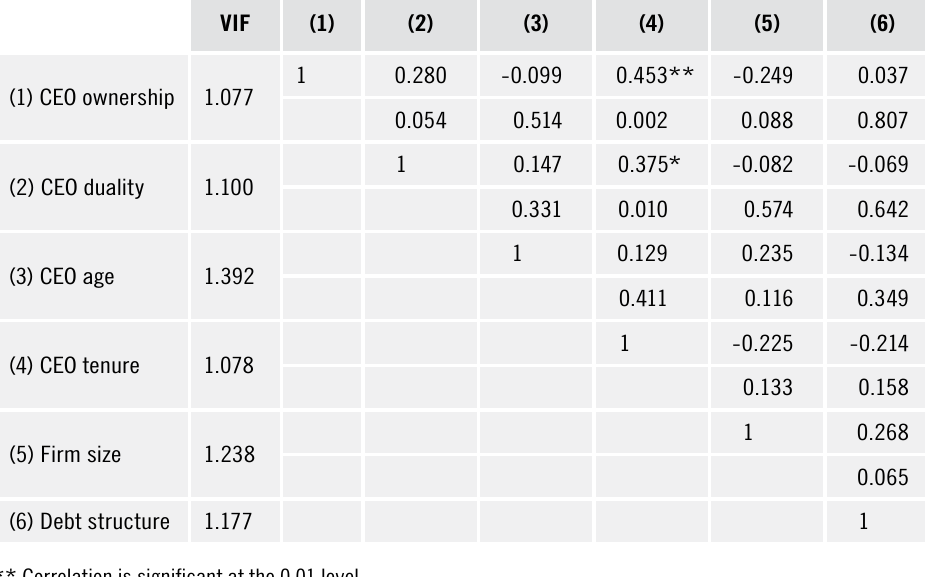
Table 10. Multicollinearity tests (variance inflation factor and Pearson’s correlation matrix)